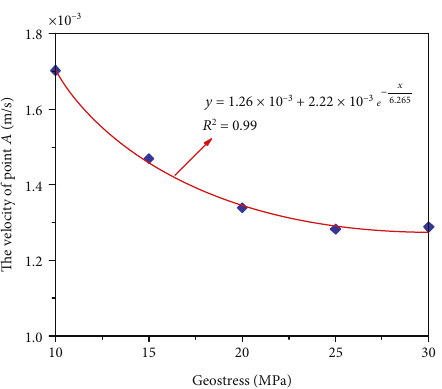
Figure 13: The relationship between the velocity change of point A and the geostress.